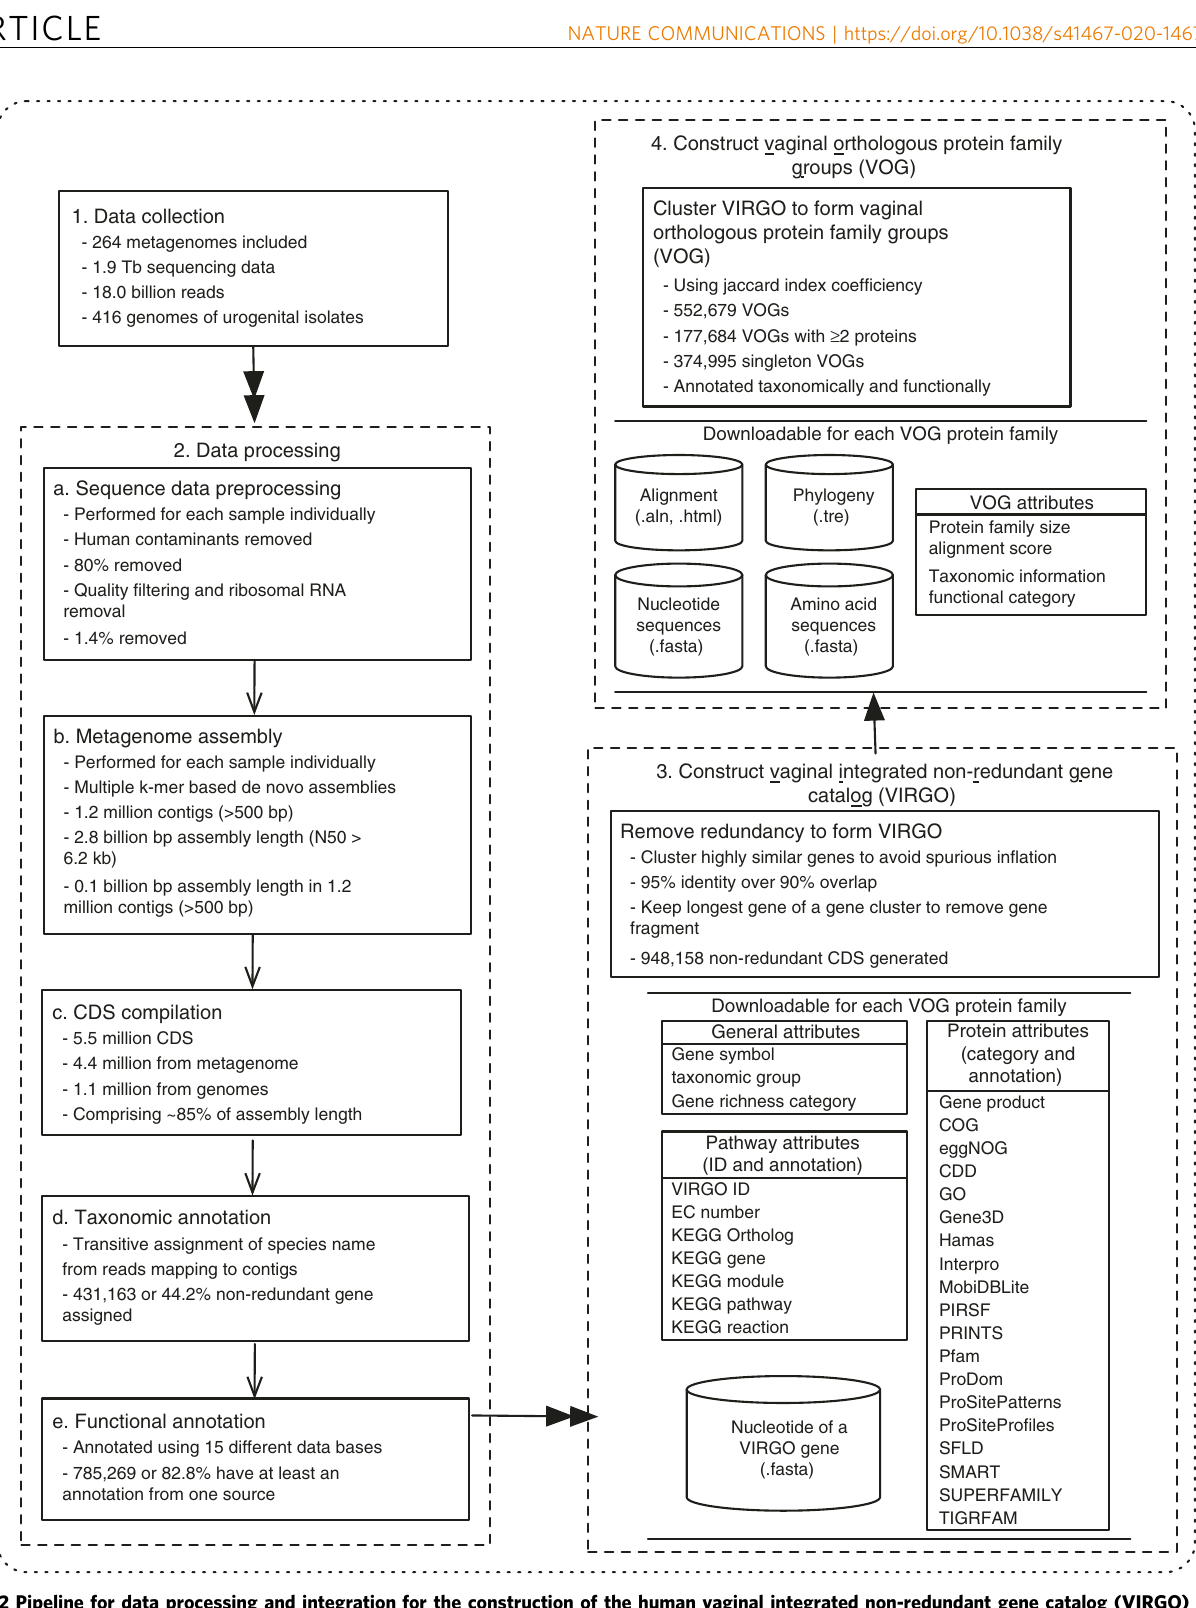
Fig. 2 Pipeline for data processing and integration for the construction of the human vaginal integrated non-redundant gene catalog (VIRGO) and vaginal orthologous groups (VOG) for protein families. Metagenomes from 264 vaginal metagenomes and 416 genomes of urogenital isolates were processed, that including 211 in-house sequenced vaginal metagenomes. The procedures include preprocessing to remove human contaminates, quality assessment, metagenome assembly, gene calling, functional, and taxonomic annotation, gene clustering based on nucleotide sequencing similarity to form VIRGO, and jaccard index coef fi ciency clustering of amino acid sequences to form VOG. A more detailed illustration is in Supplementary Fig. 5 and description is in Material and Methods